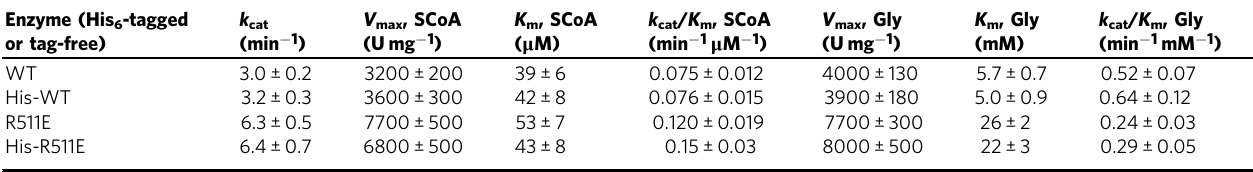
Table 2 Steady-state kinetics of recombinant hsALAS2 to study effect of His-tag and variants. Enzyme (His 6 -tagged or